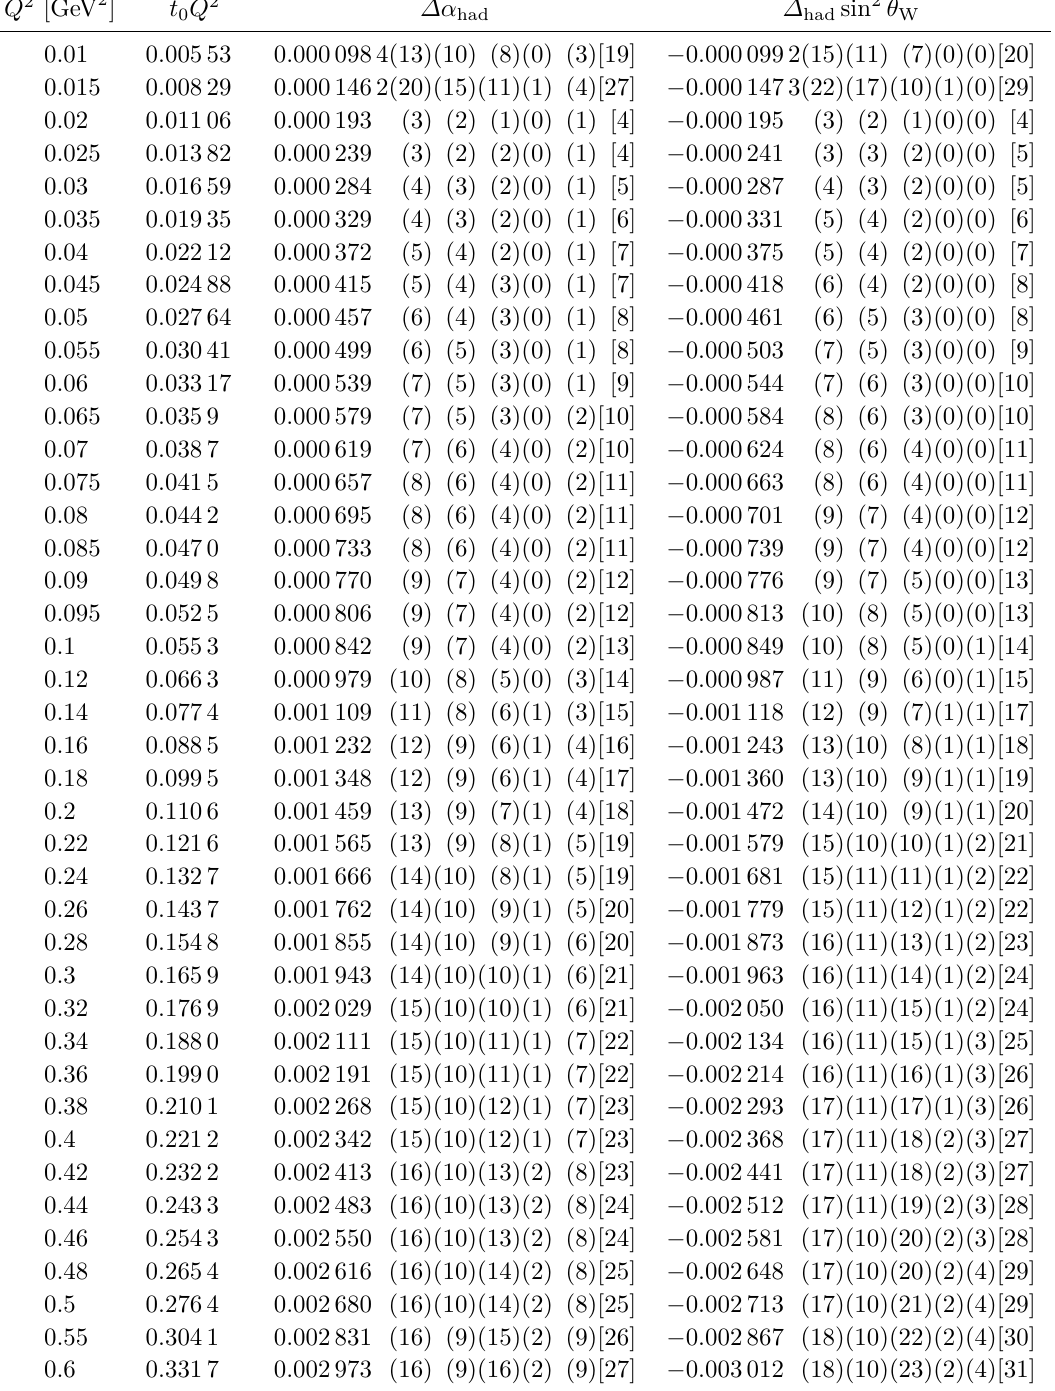
Table 13 . Results for the total HVP contribution to the running of α and sin 2 θ W extrapolated to the physical point for all the values of Q 2 sampled. Following the statistical error, and the systematic errors from varying the fit model estimated, scale-setting and missing charm sea-quark loops, the fifth uncertainty is the systematic error from missing isospin-breaking effects (see section 4.2.3). The final uncertainty, quoted in square brackets, is the combination of the previous ones